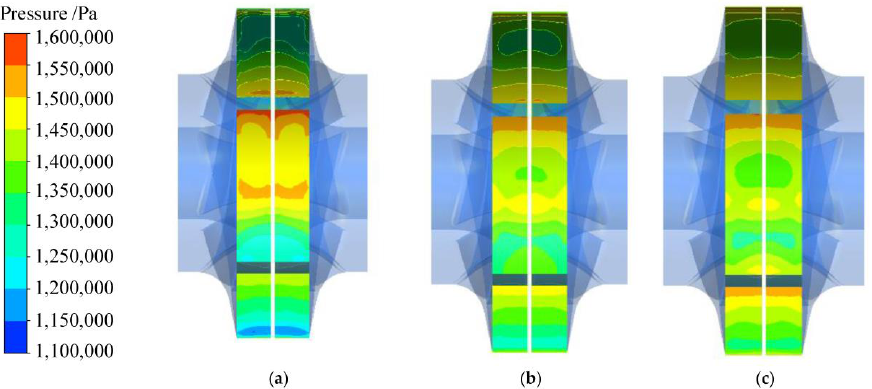
Figure 17. Static pressure near outlet of second stage impeller at three typical flow rate conditions. ( a ) 0.6 Q , ( b ) 1.0 Q , ( c ) 1.1 Q